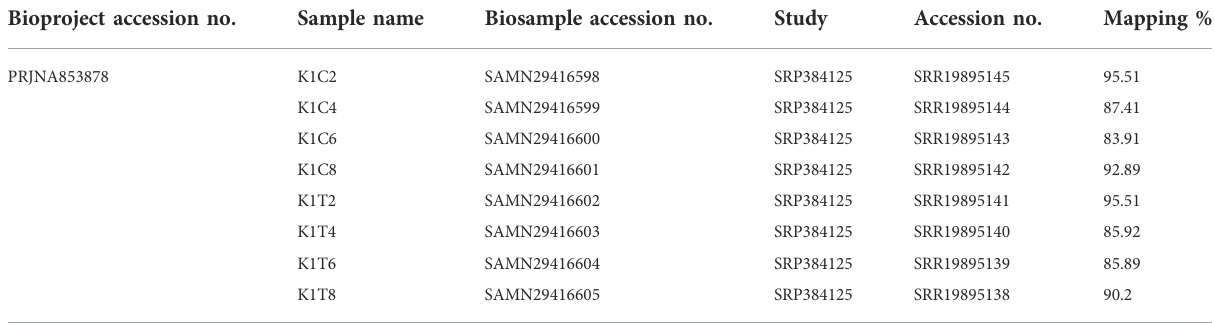
TABLE 1 Details of the biosample and short-read archive (SRA) submission of the L. rohita kidney transcriptome to the NCBI along with the mapping percentage against the reference genome. Bioproject accession